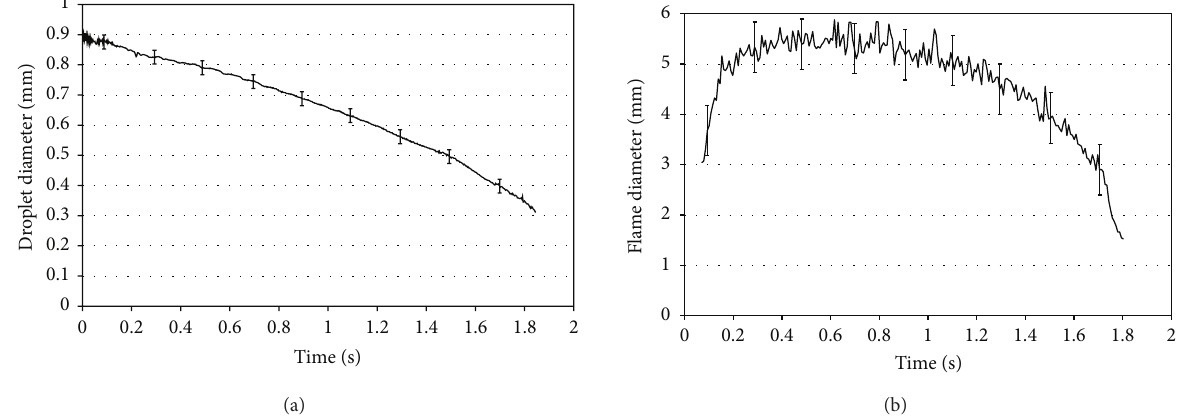
Figure 5: Representative plots of (a) droplet diameter and (b) flame diameter histories for a heptane/methanol droplet in air.